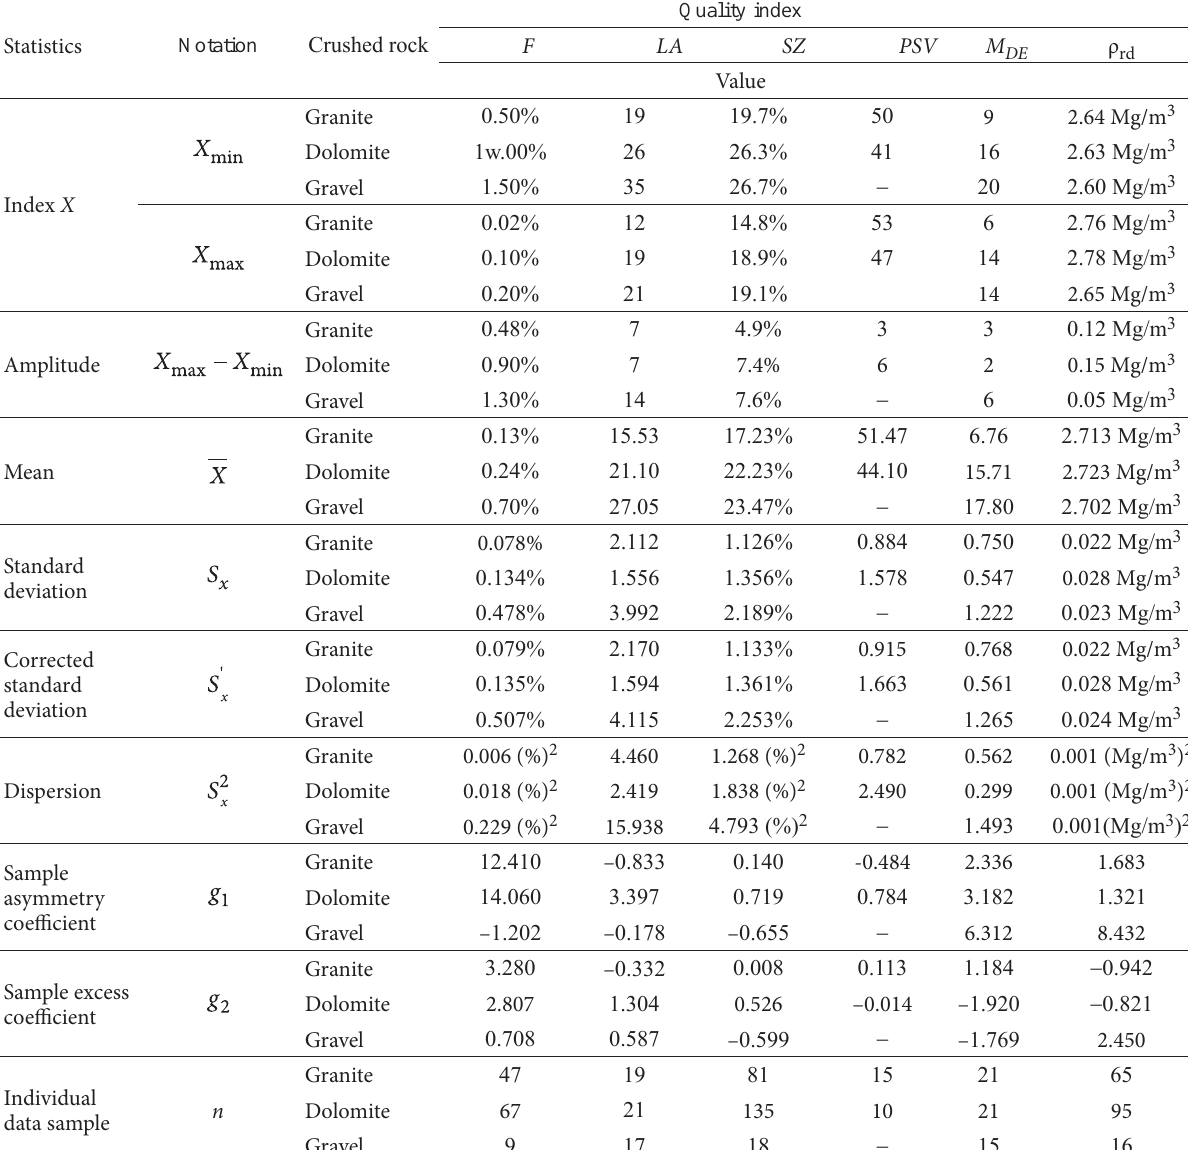
Table 1. Summary of mechanical-physical properties quality indices values